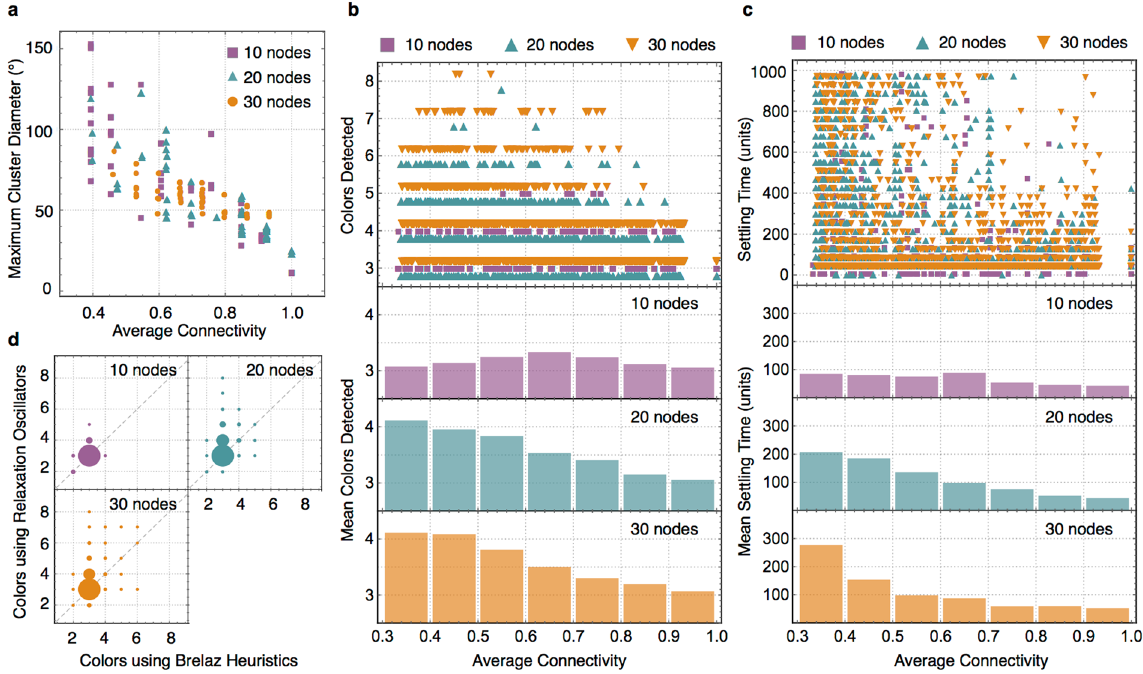
Figure 7. Simulation results on random graph instances. ( a ) Maximum cluster diameter for those graphs for which 3 colors were detected. ( b ) (Top) Number of colors detected plotted against the average connectivity. (Below) Mean colors detected in connectivity intervals. ( c ) (Top) Settling time plotted against the average connectivity. (Below) Mean settling time in connectivity intervals. ( d ) Number of colors detected using the relaxation oscillator circuit plotted against number of colors detected using Brelaz heuristics for the random graph instances used in b and c. Each graph instance represents a point whose coordinates are denoted by the pair of colors detected using the two methods. The size of dots represents the percentage of instances which lie at the center of corresponding dot.